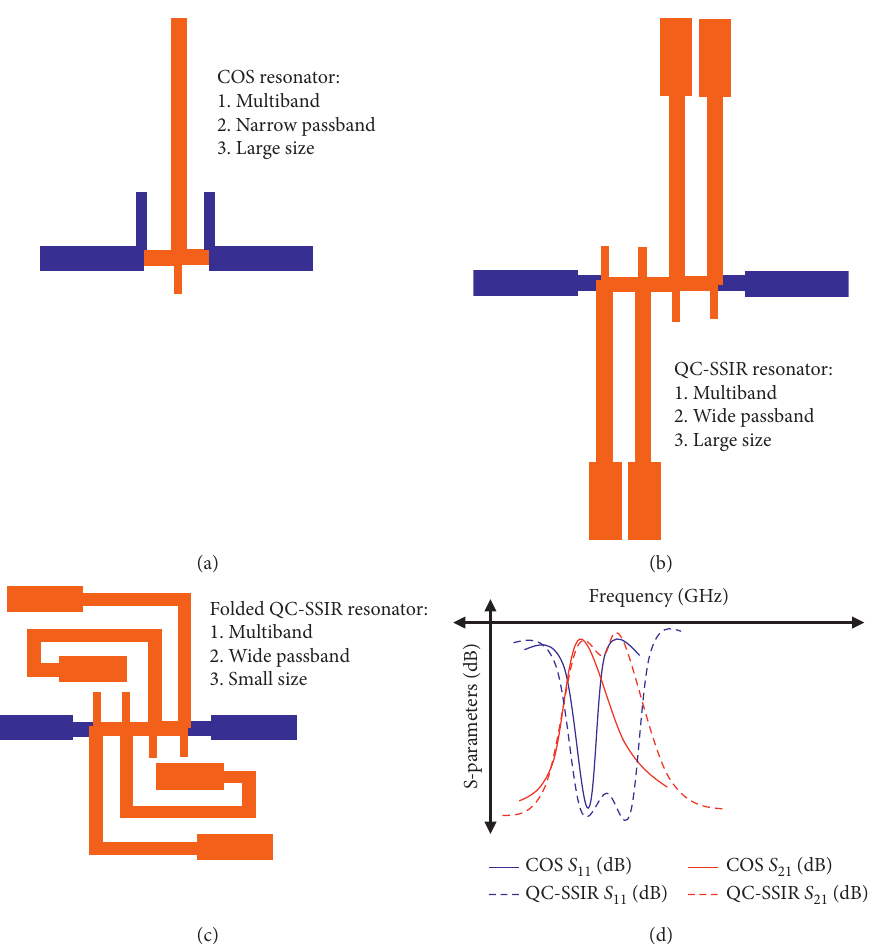
Figure 1: The resonator structure: (a) crossed open stub resonator, (b) quad cross-stub stepped impedance resonator (proposed), (c) folded quad cross-stub stepped impedance resonator (proposed), and (d) comparison of bandwidth of the COS and QC-SSIR structure.